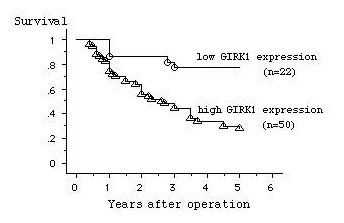
Overall survival of 72 lung cancer patients according to GIRK1 amplification. Survival curves were calculated by the Kaplan-Meier method, and statistical evaluation was determined by the log-rank test (p = 0.0004).